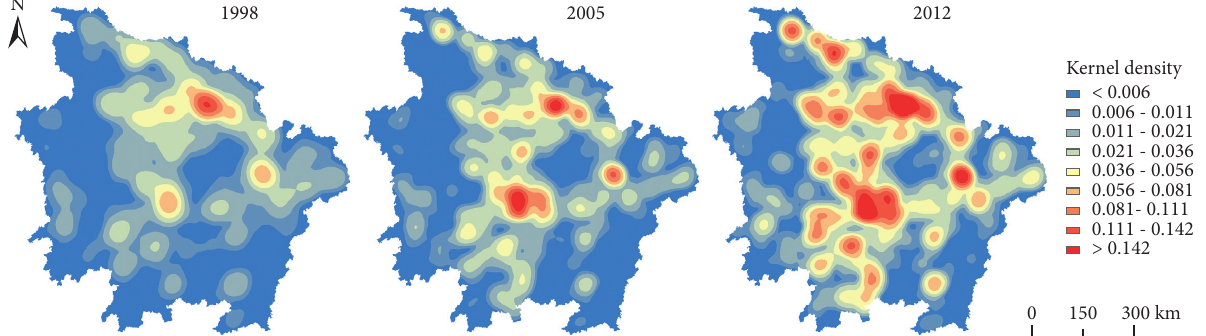
Figure 5: Kernel density estimation of water pollution-intensive enterprises in the middle reaches of the Yangtze River Economic